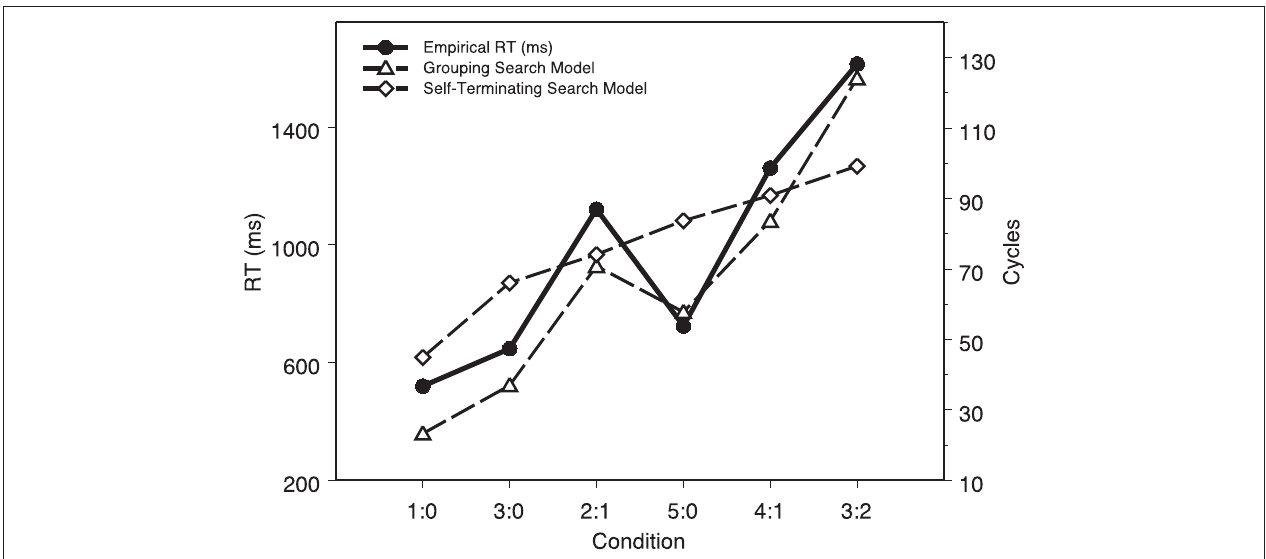
Figure 4 | Computational modeling results (in cycles) as a function of task conditions, together with the empirical data (in milliseconds) reported in Fan et al.